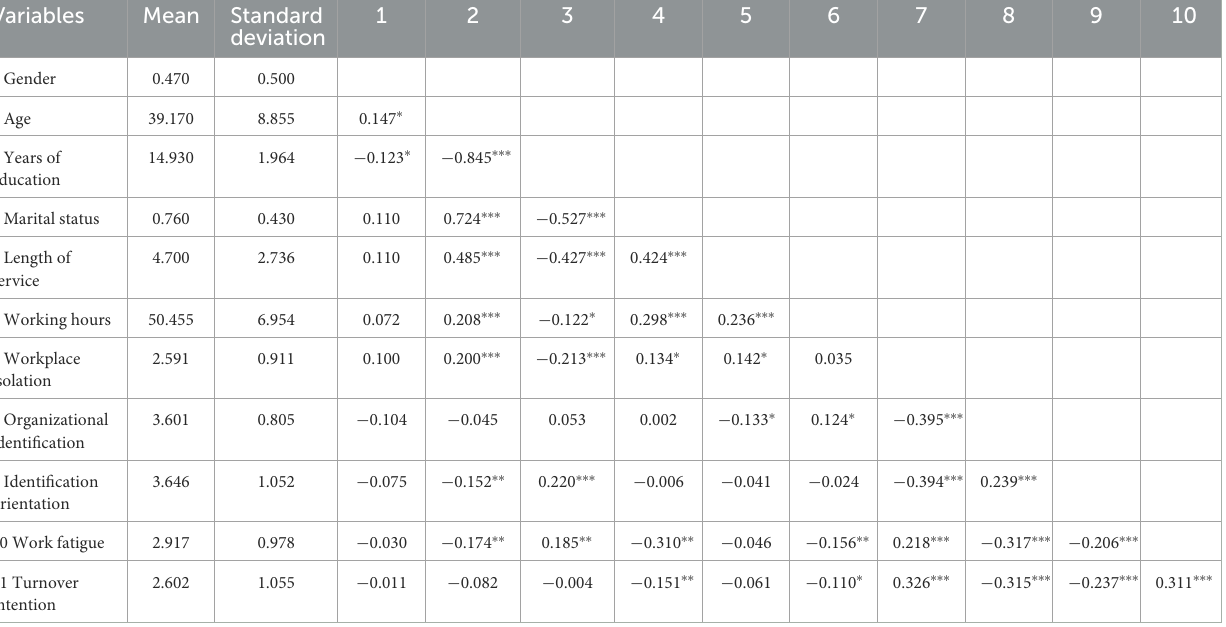
TABLE 3 Mean values, standard deviations and correlation coefficients of variables ( N =